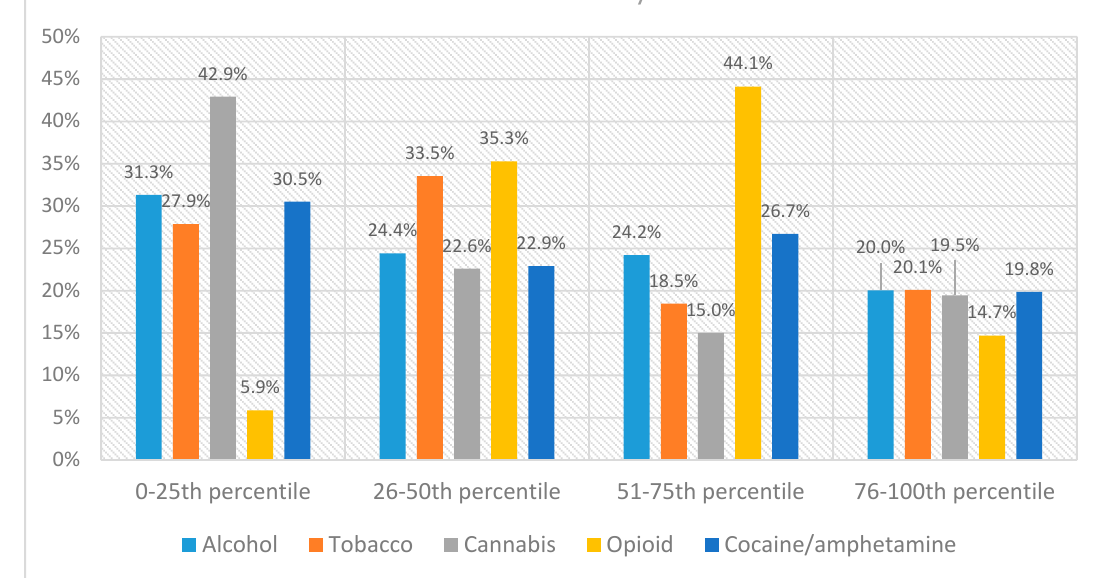
Figure 1. Demographic distribution of conduct disorder inpatients by substance use disorders.